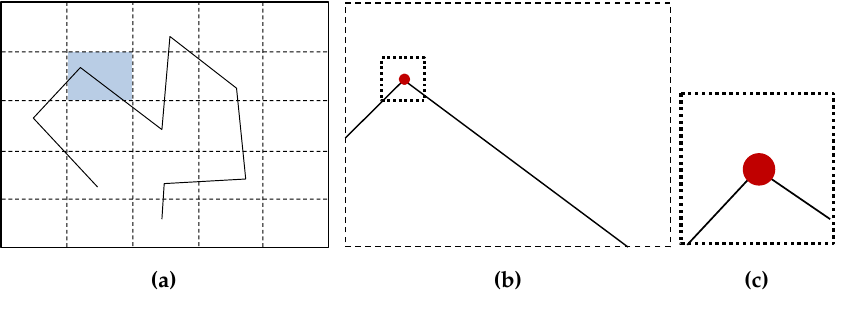
Figure 5. Point detection process. ( a ) Image divided into regions; one is randomly selected; ( b ) selected region, processed to find a corner point; ( c ) appearance of the